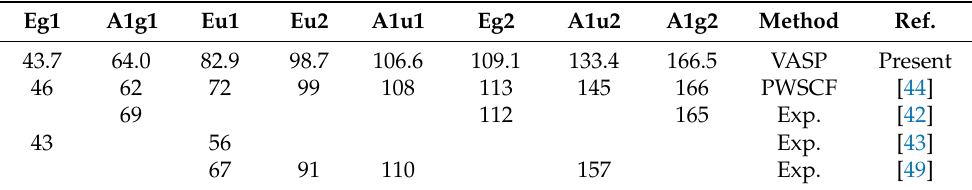
Table 2. Calculated phonon frequencies (in cm − 1 ) from the present and previous studies at the zone center for Sb 2 Te 3 , as well as the available experimental